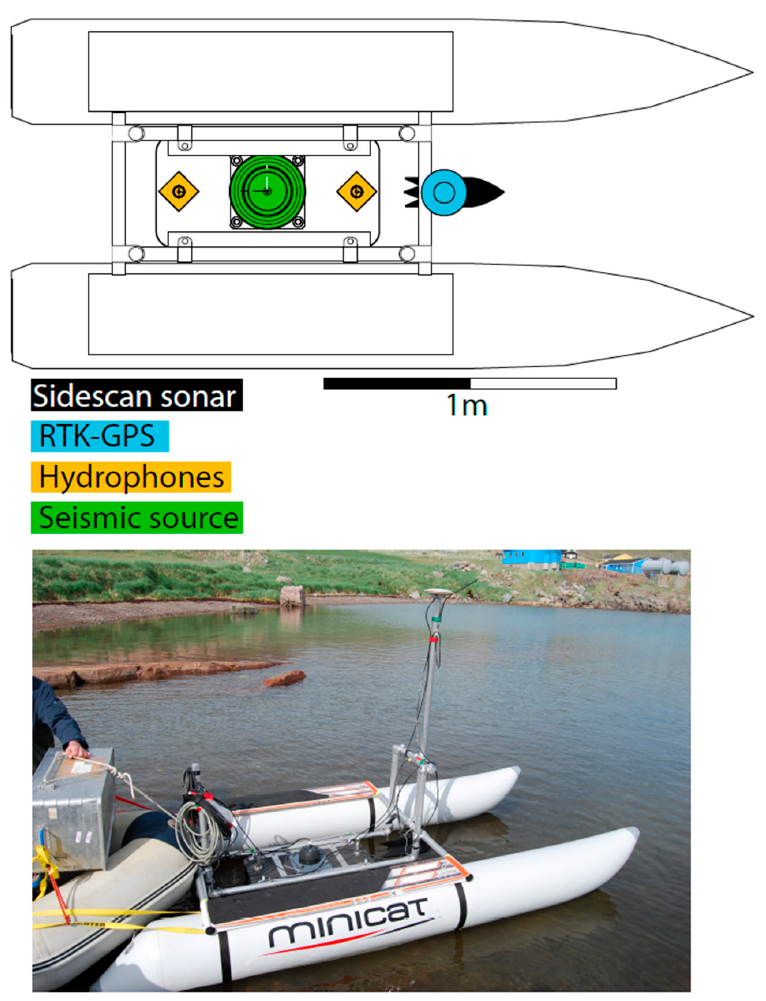
Figure 3. Sketch and picture of the seismic and sonar acquisition system that was attached to the front of a rubber dinghy.